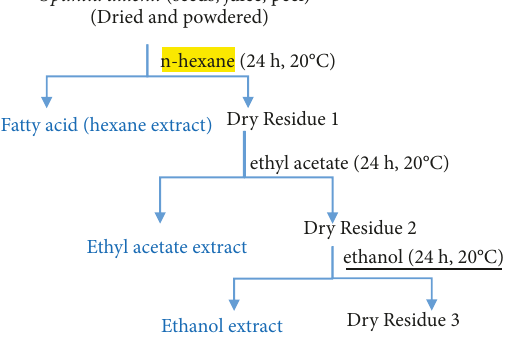
Dry Residue 1 Fatty acid (hexane extract)